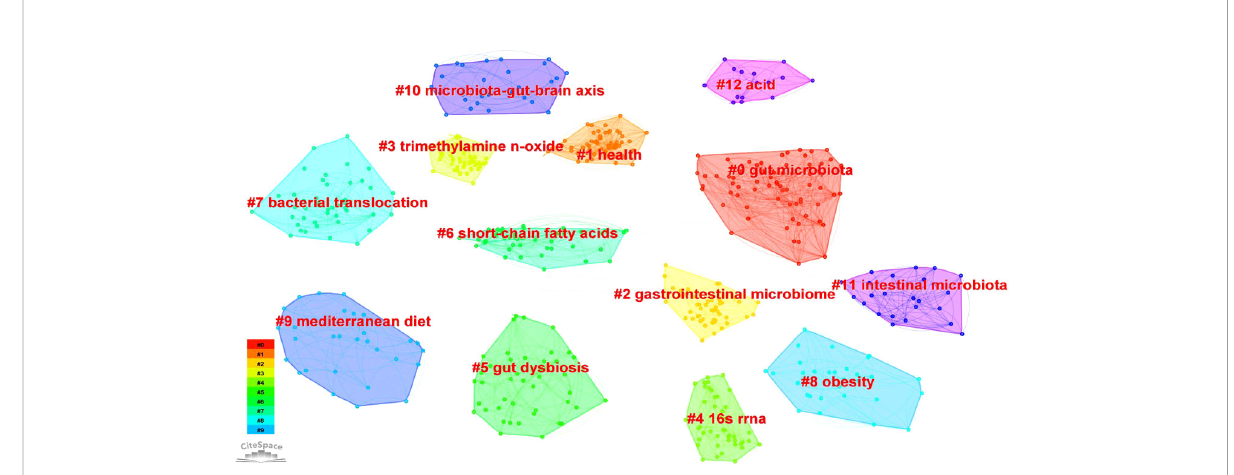
FIGURE 6 Visual analysis of top ten clusters decided by the keywords on GM in CVD performed by